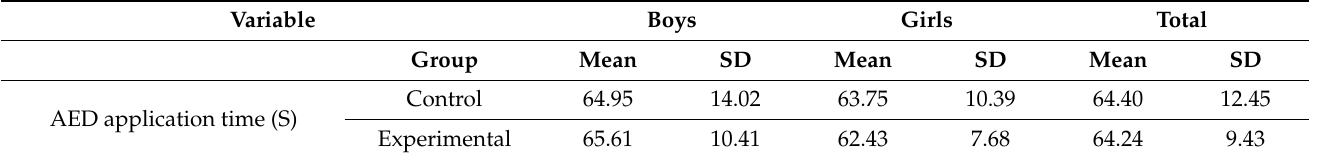
Table 5. Descriptive statistics of the time variable according to sex and total number of